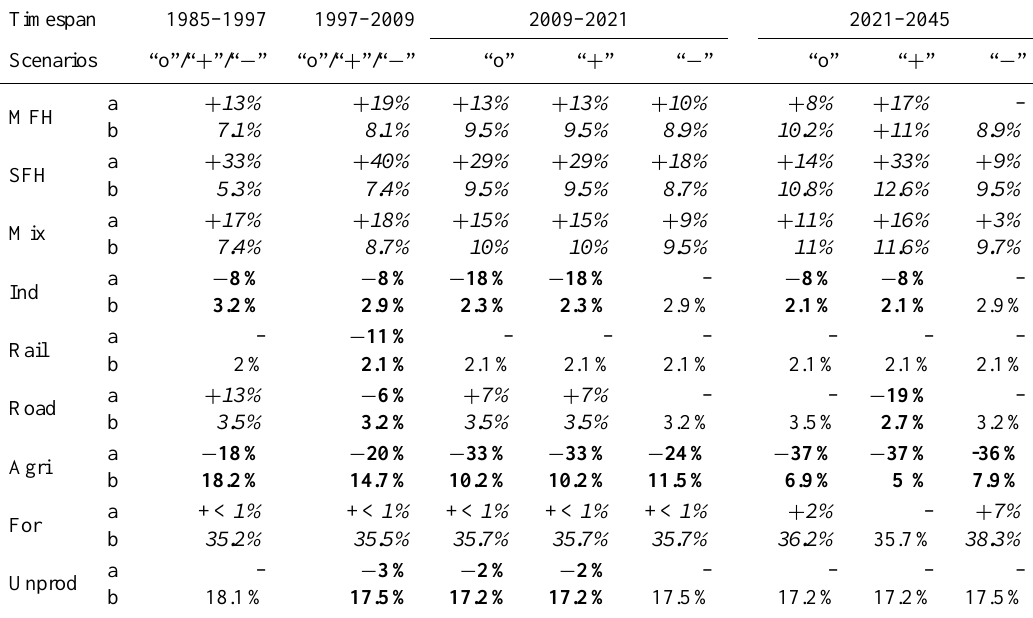
Table 4. Changes in land use for each scenario as a result of quantified driving forces; bold indicates a decrease and italic an increase of the area. Each value in every time period relates (a) to the total number of cells of the previous time span and (b) to the percentage of land-use class of the total area per time span. For explanation of the abbreviations see Table 1.